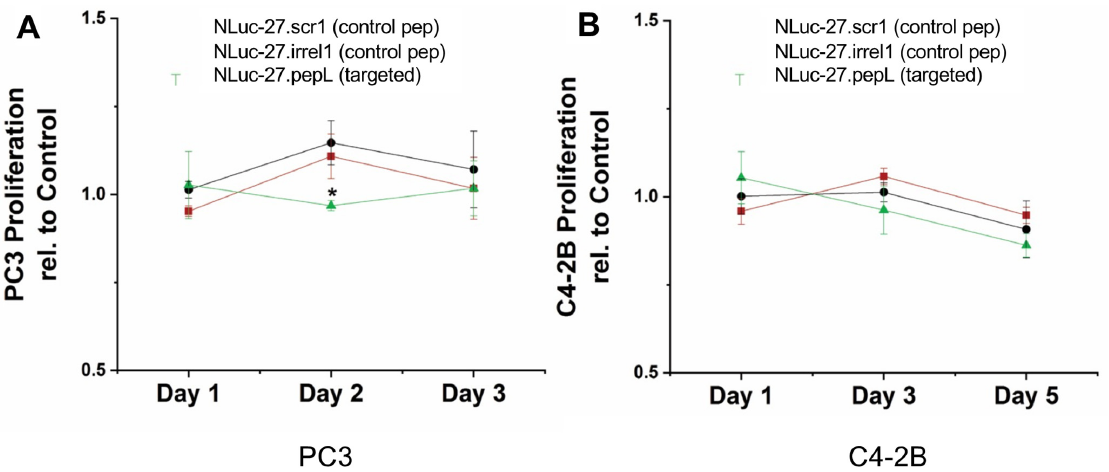
Figure 8. Effect of targeted Nluc-27.pepL-conditioned media on cancer-cell proliferation. ( A ) Cells that displayed moder-ate levels of IL-6R α , PC3 cells, and ( B ) cells that overexpressed IL-6R α , C4-2B cells. Only the cells treated with targeted Nluc-27.pepL exhibited a trend in the reduction in cell proliferation relative to the empty-vector control group. Data are presented as mean ± SEM. Comparisons within cell types were performed using one-way ANOVA. A p-value < 0.05 indi-cates a significant difference (*). Red squares, Nluc-27.scr1 (control peptide), black circles, Nluc-27.irrel1 (control peptide), and green triangles, Nluc-27.pepL (targeted).